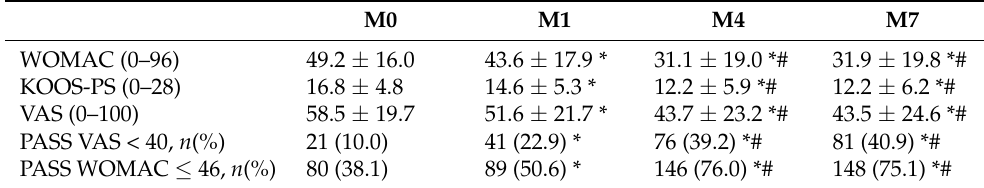
Table 2. Variations over baseline in pain and function scores at 1, 4, and 7 months after PRP